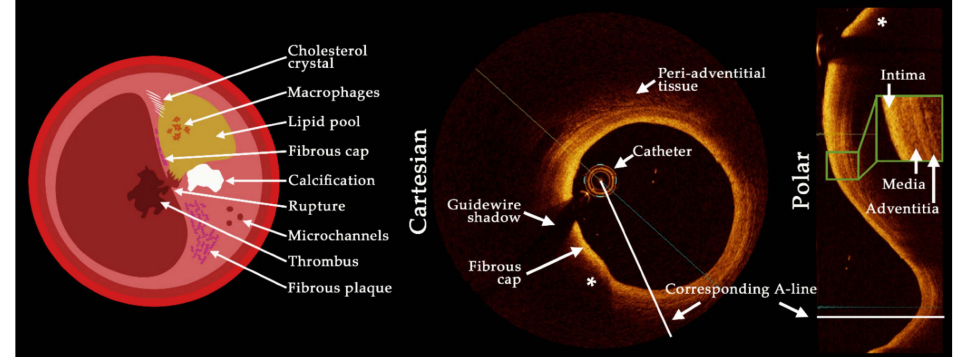
Figure 1. Schematic showing plaque features visible with optical coherence tomography (OCT) imaging as well as a visualization of A-lines in the cartesian and polar coordinates. The OCT images show a lipidic plaque (*) with fibrous cap and the delineation of the three artery wall layers is shown inset in the polar image representation. The limited penetration depth can be seen behind the lipidic component, with significant attenuation preventing visualization of the backside of plaque